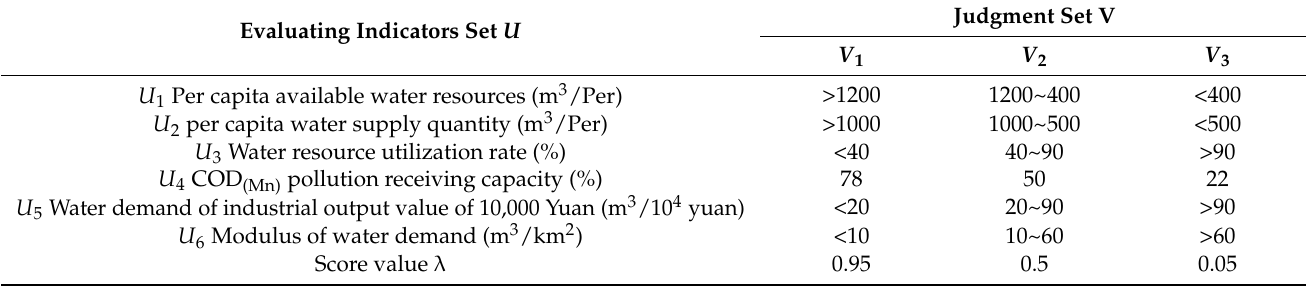
Table 2. Evaluation standard of WRCC grading